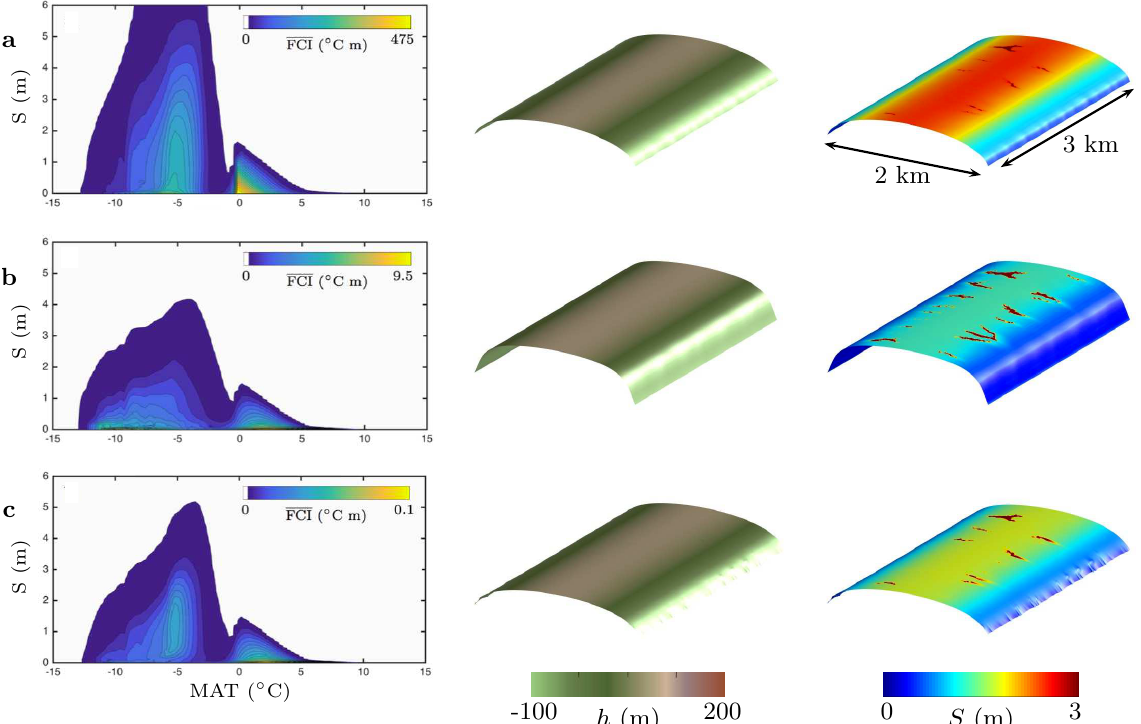
Figure 14. Summit-flat evolution using FCI patterns resulting from different assumptions regarding water availability (see also Andersen et al., 2015, Fig. 11). Panel (a) : frost cracking occurs whenever water is present in the direction of increasing temperature (resembling the model by Hales and Roering, 2007). Panel (b) : the distance from site of frost cracking to the nearest water source ( T > 0 ◦ C) scales FCI in accordance with the model of Anderson et al. (2012). Panel (c) : like (b) , but now porosity and water fraction at the water source affect FCI as in Andersen et al. (2015). Compared to our standard model (Fig. 3), (c) has constant flow restriction parameters (2m − 1 ). Apart from the difference in FCI, all three model simulations are identical to our experiment 1 (Sect. 3.1). The differences in how the three FCIs depend on sediment thickness clearly influence the sediment thickness. However, although surface curvature and final sediment distribution vary, all three models inevitably result in the development of a summit